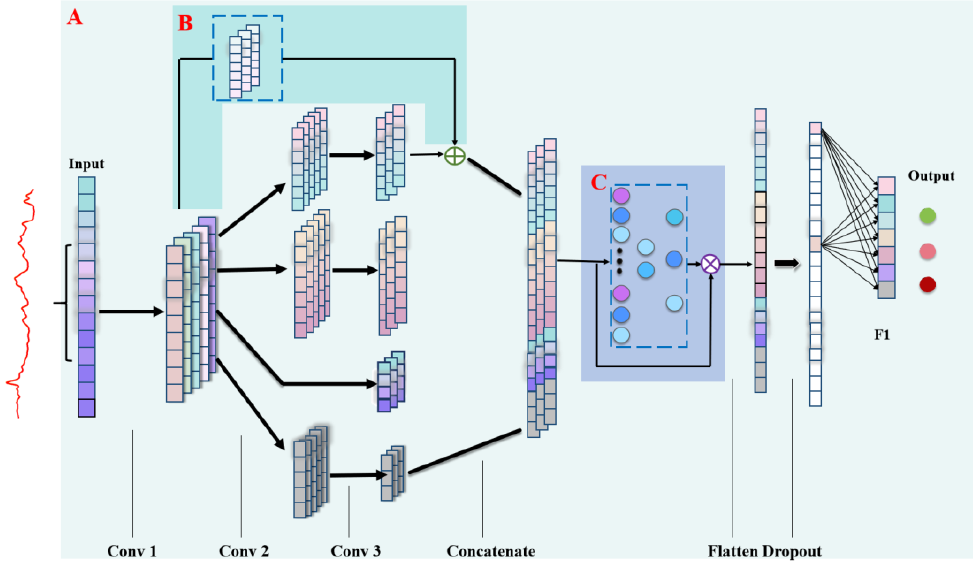
Figure 2. Structures of improved Inception networks: Inception ( A ); residual module ( B ); channel attention module ( C ). The blocks in the dotted boxes are added or subtracted based on the experiments.